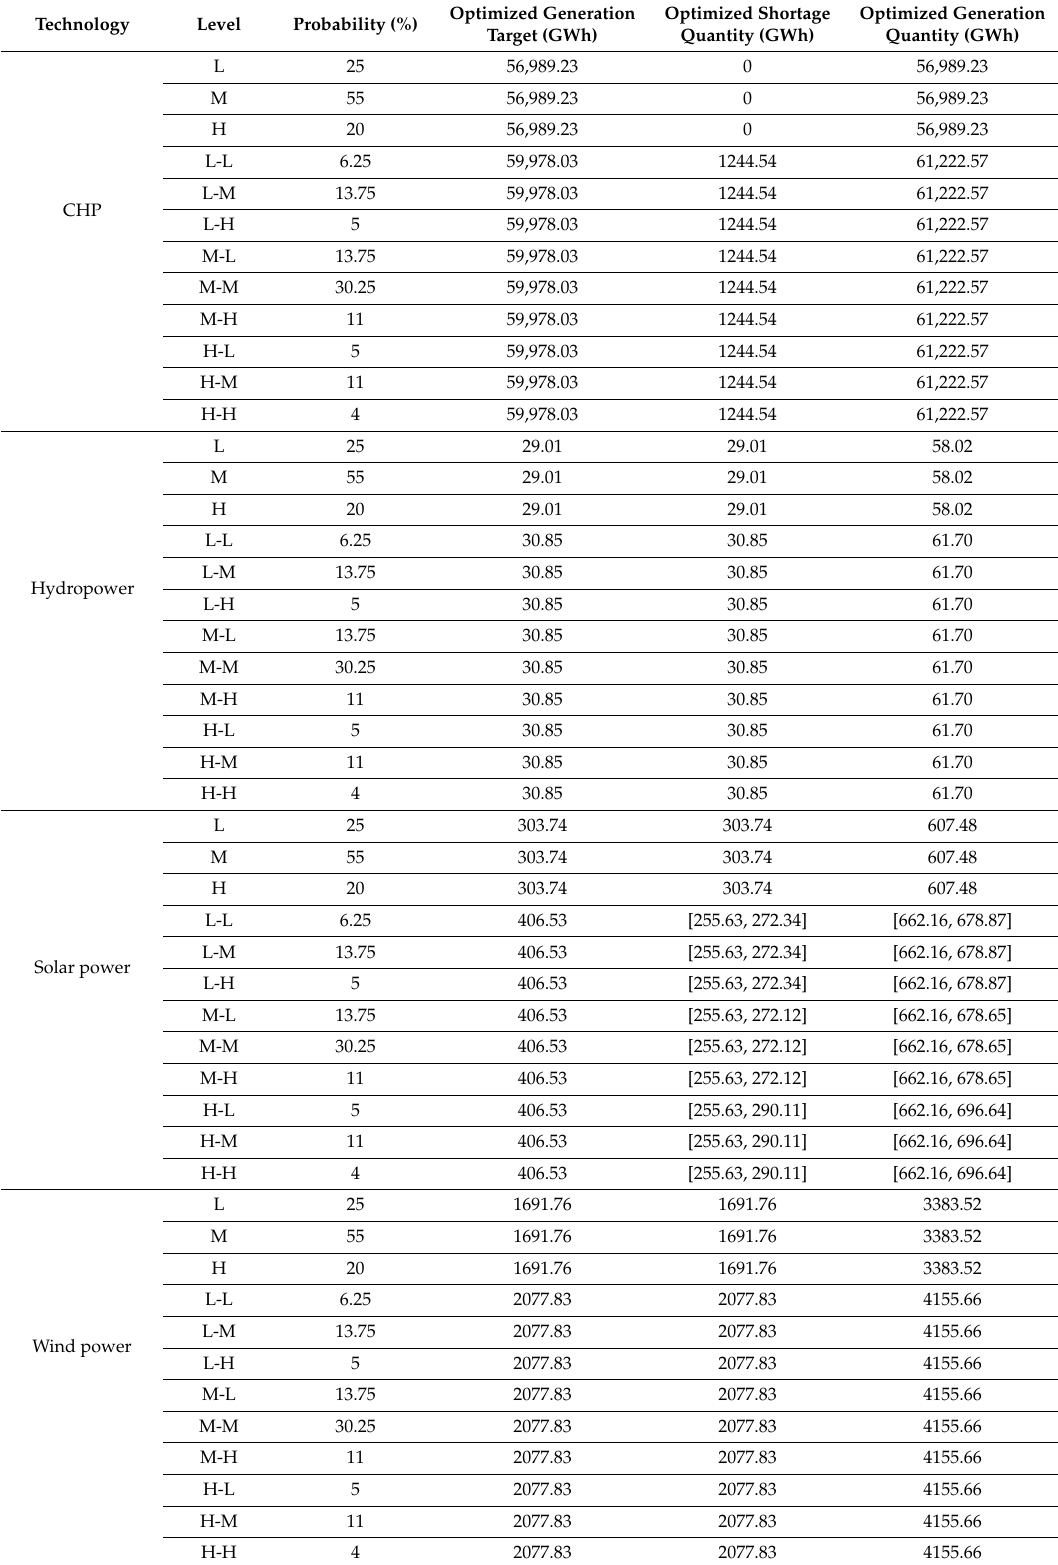
Table 5. The optimized power generation schemes under λ =